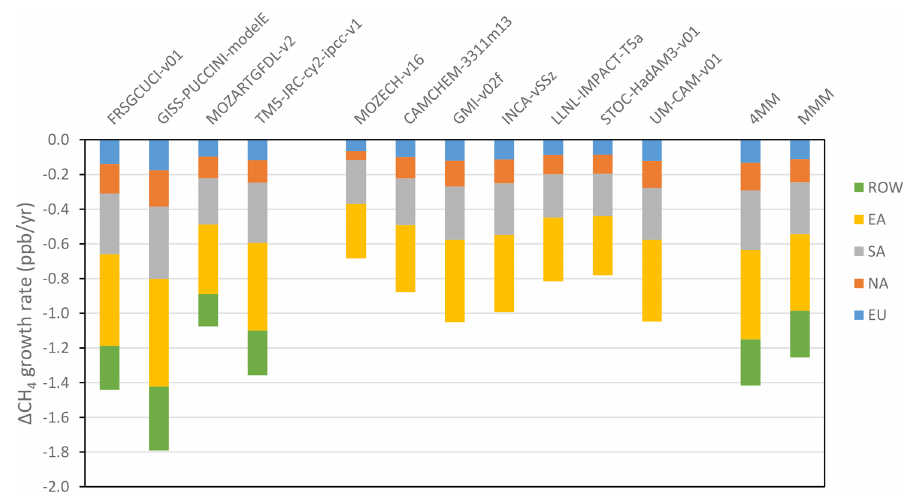
Figure 6. As in Fig. 5 but for CO emissions.